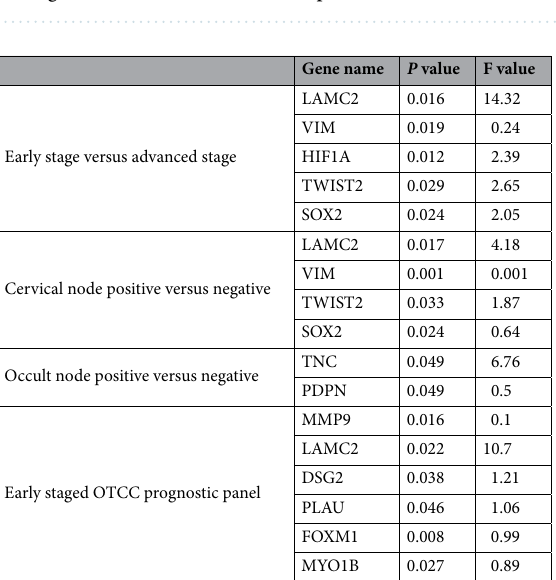
Figure 2. Heatmap representing the expression levels of the significant differentially expressed marker genes among the normal and OTSCC samples.